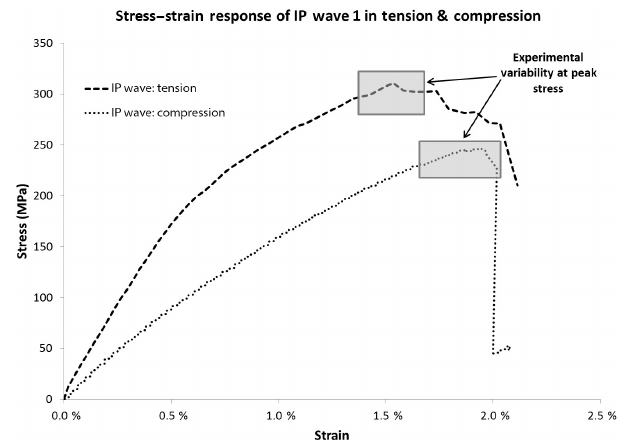
Figure 12. Stress–strain of IP wave 3 in tension and compression utilized for baseline model correlations with associated experimen- tal variability.